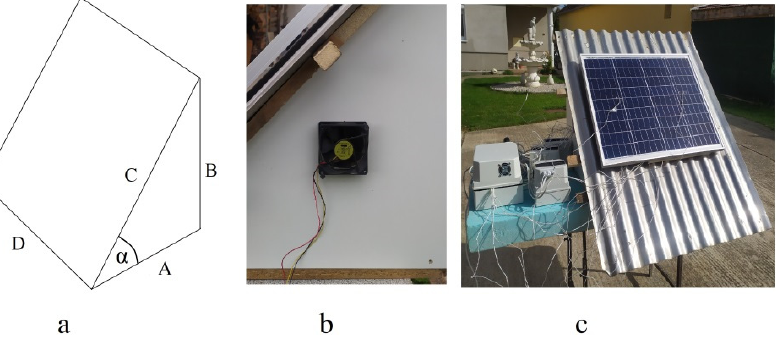
Figure 1. ( a ) The model dimensions designation; ( b ) detail of model building with fan integrated on the facade; ( c ) the experimental equipment with photovoltaic (PV) module on the